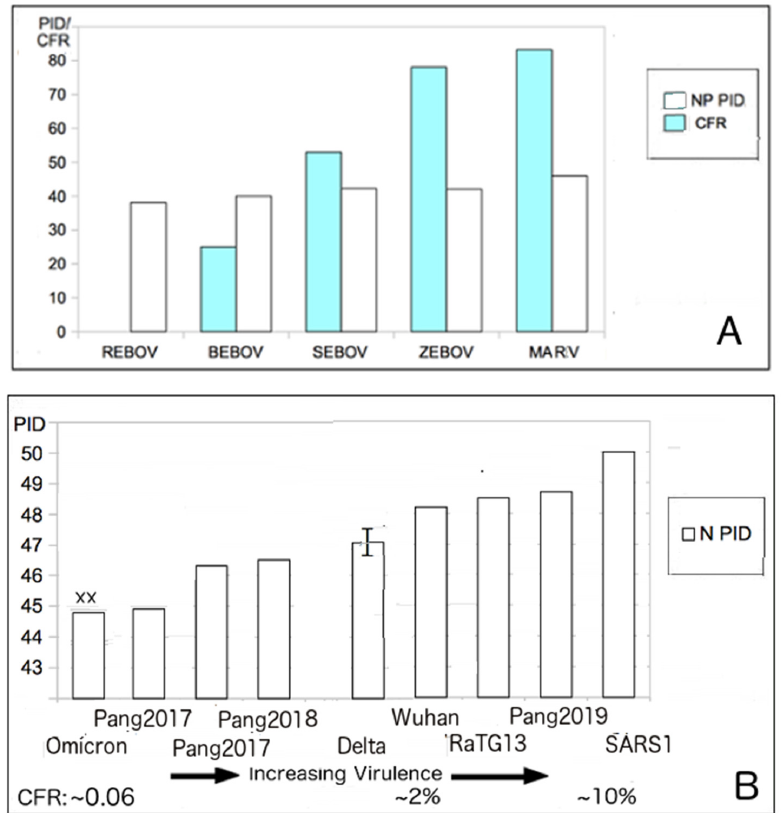
Figure 2. The virulence–inner shell disorder model. ( A ). Correlation of the Ebola (EBOV) virulence and inner shell (NP) disorder (r = 0.95, p < 0.05) [21]. ( B ). Correlation between SARS virulence and the inner shell (N) disorder (r = 0.8, p < 0.05). Abbreviations: Pangolin-CoV 2017–2019 (Pang2017–Pang2019). SARS-CoV-1 (SARS1), Wuhan (Wuhan-Hu-1), Reston EBOV (REBOV), Bundibugyo (BEBOV),